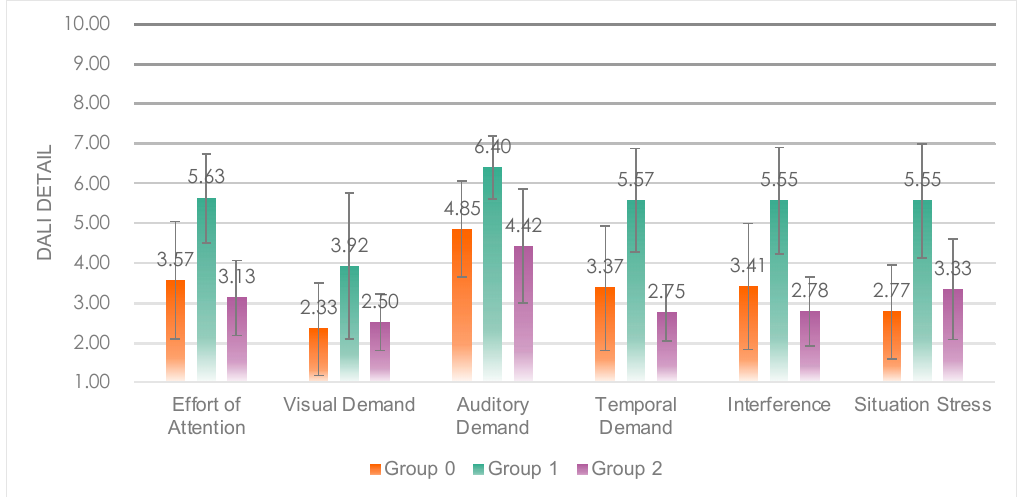
Figure 10. Detail values of the DALI scale of the three groups.